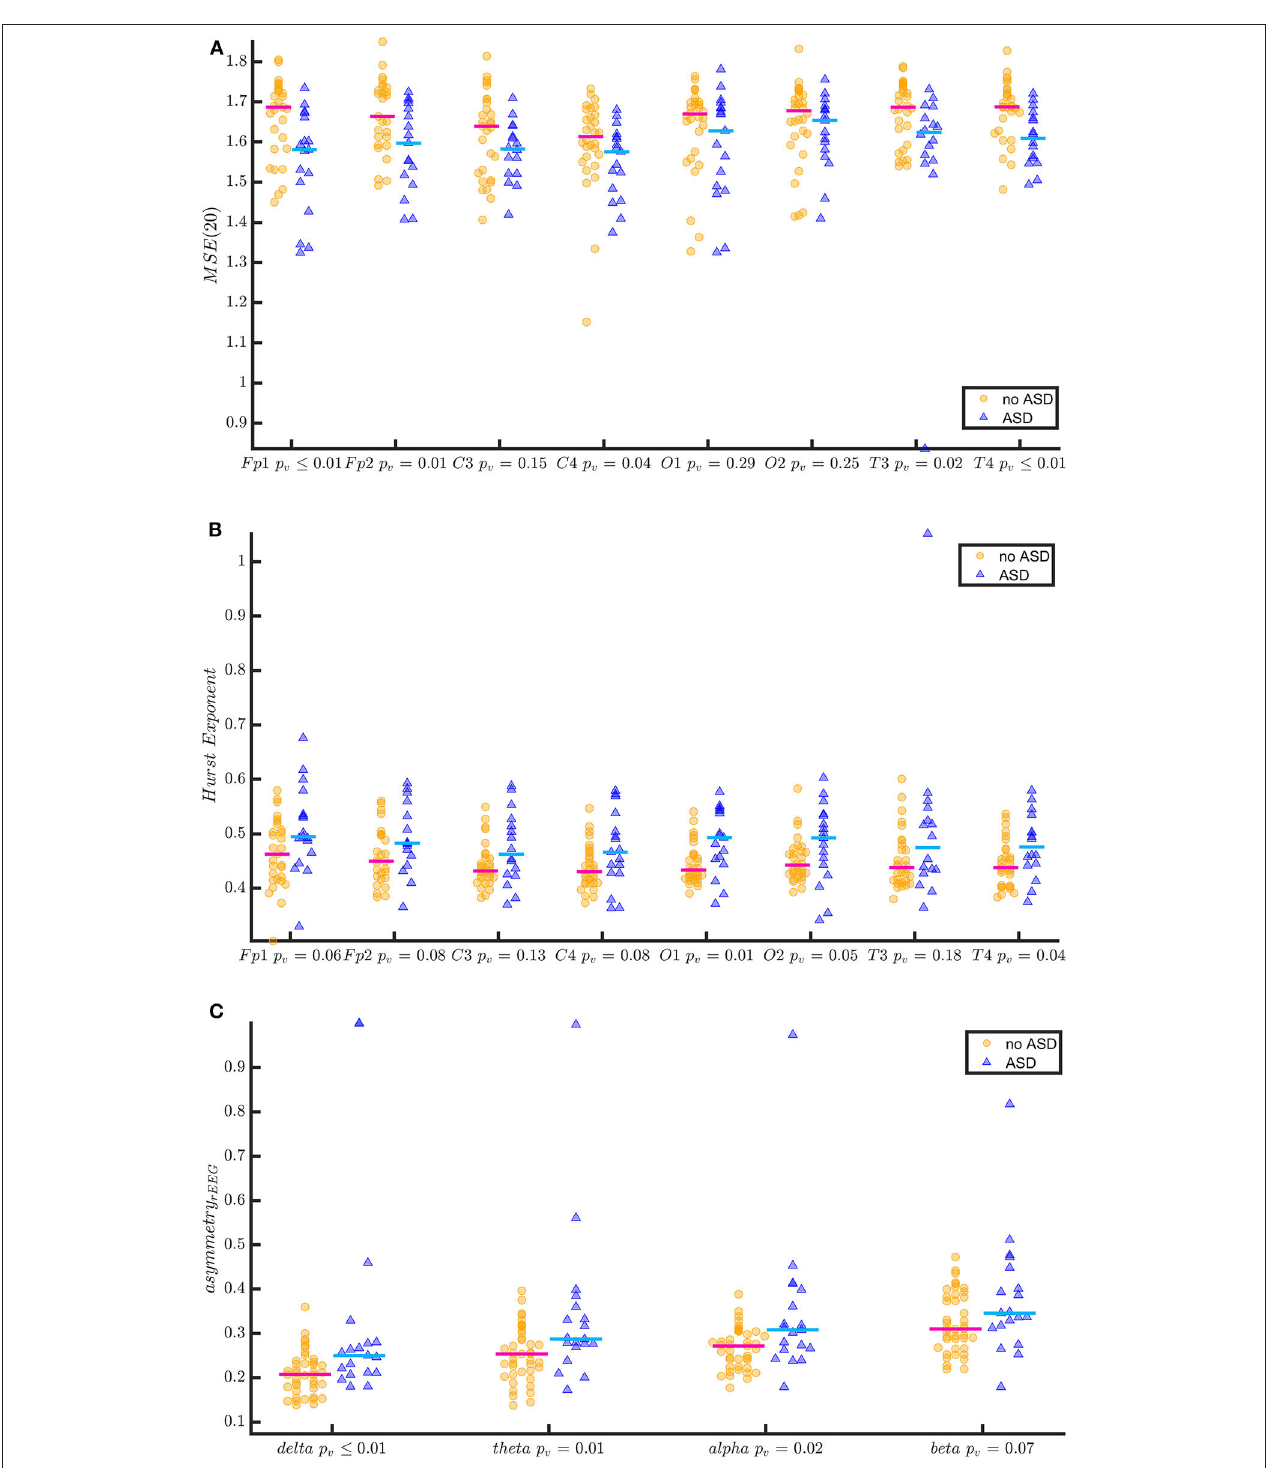
FIGURE 2 | Quantitative EEG features of TSC patients with and without ASD at the age of 24 months. The figure shows the entropy at scale 20 [MSE(20)] (A) Hurst Exponent (B) and the asymmetry of the range EEG (C) (estimate of amplitude integrated EEG) in two groups (no ASD vs. ASD at 24 months). The EEGs of patients with ASD at 24 months show a more asymmetric range EEG, a higher Hurst Exponent (more regularity) and lower entropy at lower frequencies [MSE(20)] (less complexity). In (A,B) , the comparisons are reported for each EEG channel. In (C) , the comparisons are reported for the frequency bands. P -values have been derived by Kruskal-Wallis